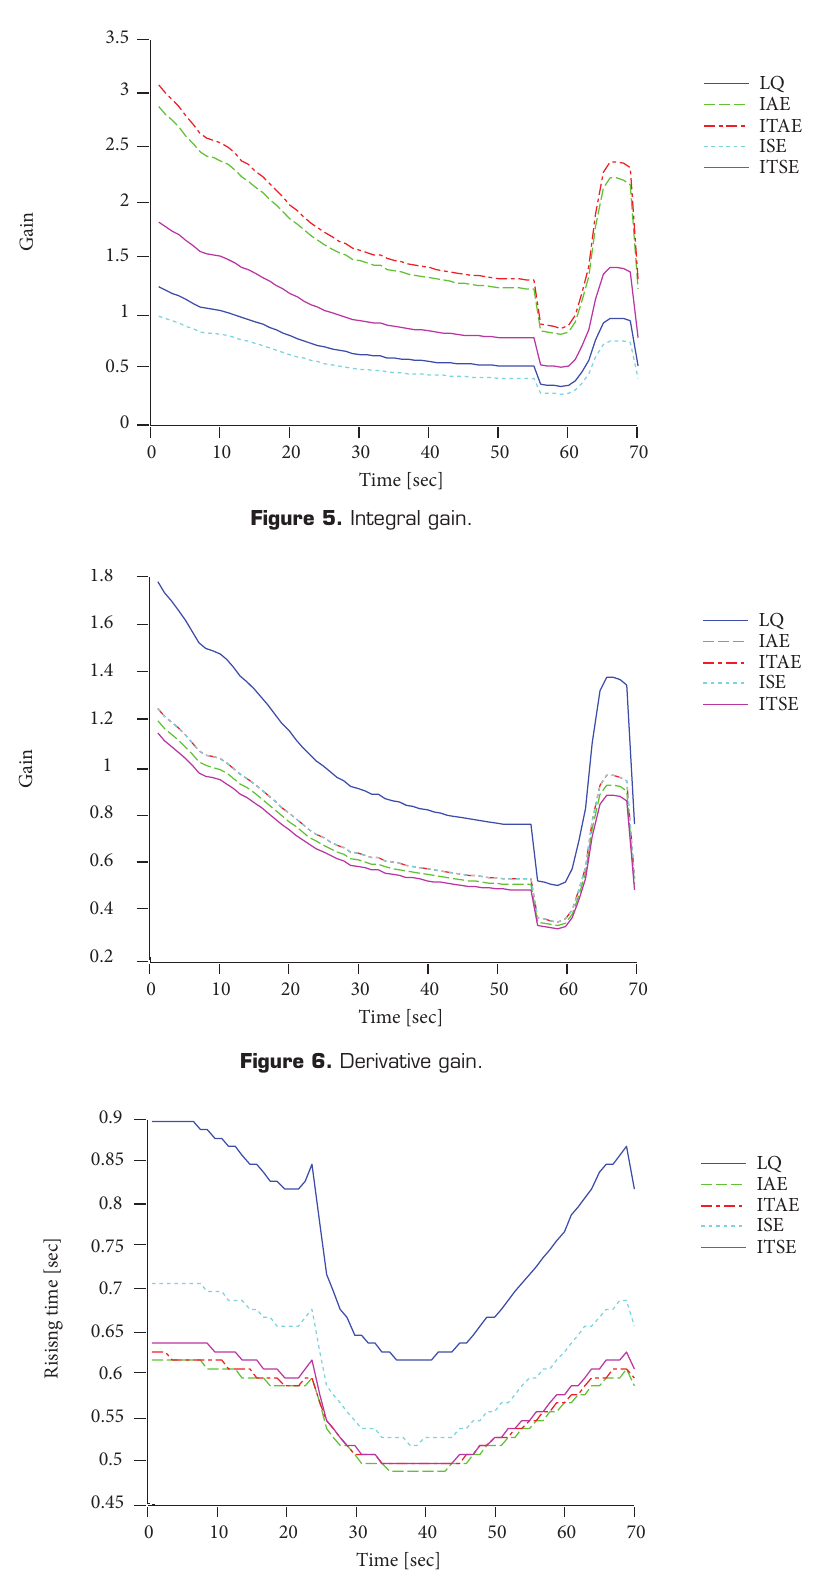
Figure 7. Rising time.